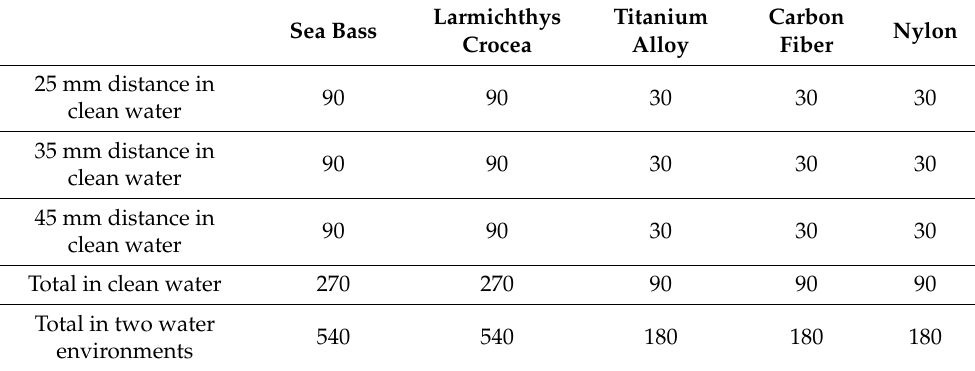
Total in clean water Total in two water